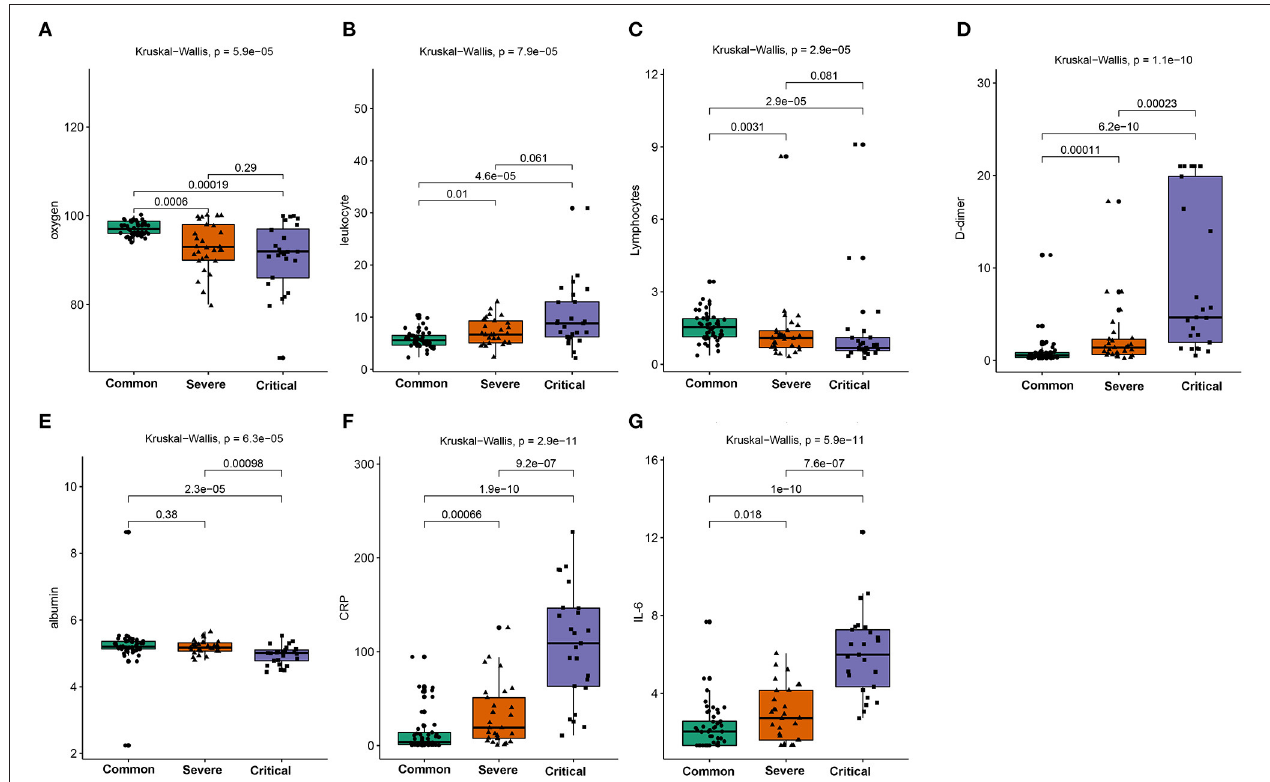
FIGURE 1 | Comparison of the oxygen saturation (A) , leukocytes (B) , lymphocytes (C) , D-dimer (D) , albumin (E) , CRP (F) , and IL-6 (G) in the common, severe, and critical types of COVID-19 patients.